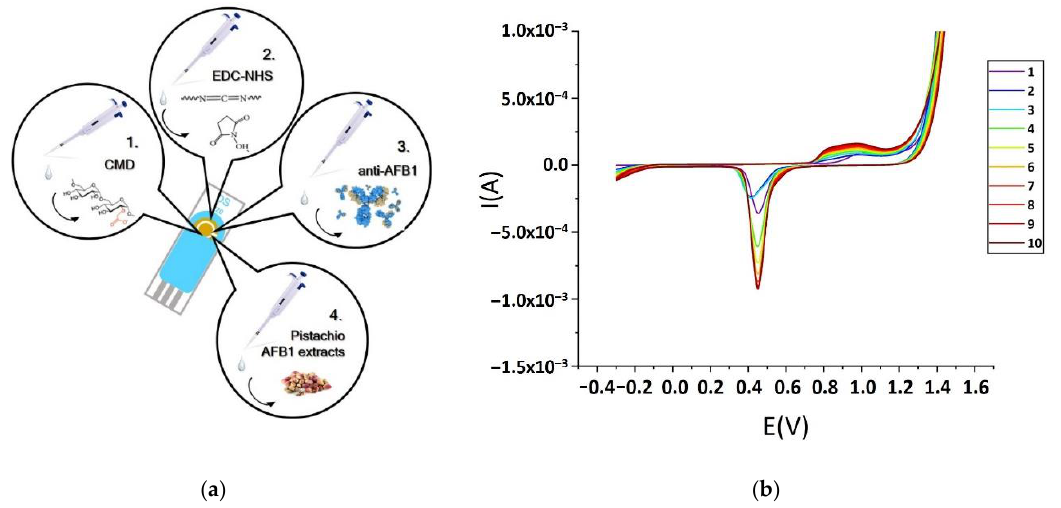
Figure 1. Schematic representation of the successive steps of anti-AFB 1 immobilization procedure ( a ). Ten cyclic cleaning voltammogram of the Au screen-printed electrode (SPE) electrode ( b ).